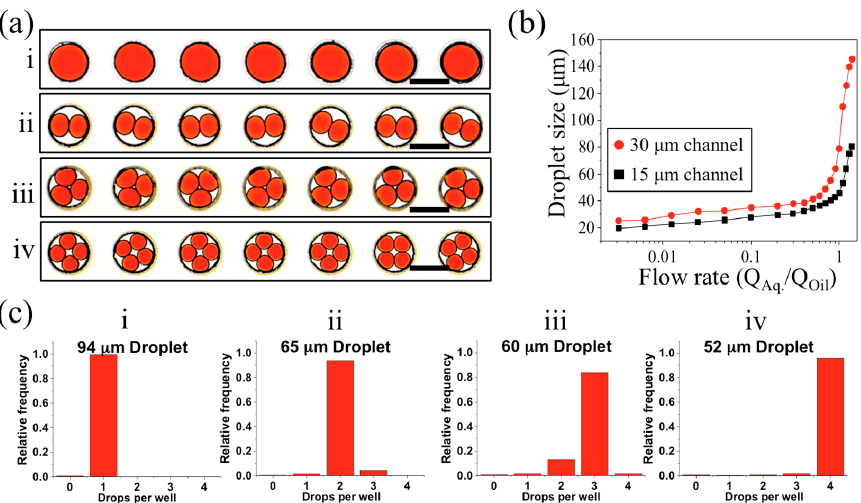
Figure 7. Controlling the number of droplets per well. ( a ) Microscopic image showing multi-droplet clustering in 120 μ m wells; one droplet per well (i), two droplets per well (ii), three droplets per well (iii) and four droplets per well (iv). Scale bars =120 μ m. ( b ) Controlling droplet size by manipulating the flow rate ratio (water/oil) for 30 × 50 μ m channel (red) and 15 × 50 μ m channel (black). ( c ) Distribution of droplet occupancy in 120 μ m wells for droplets with a diameter of (i) 94, (ii) 65, (iii) 60, and (iv) 52 μ m. Occupancy was quantified based on analysis of at least 432 wells for each group.